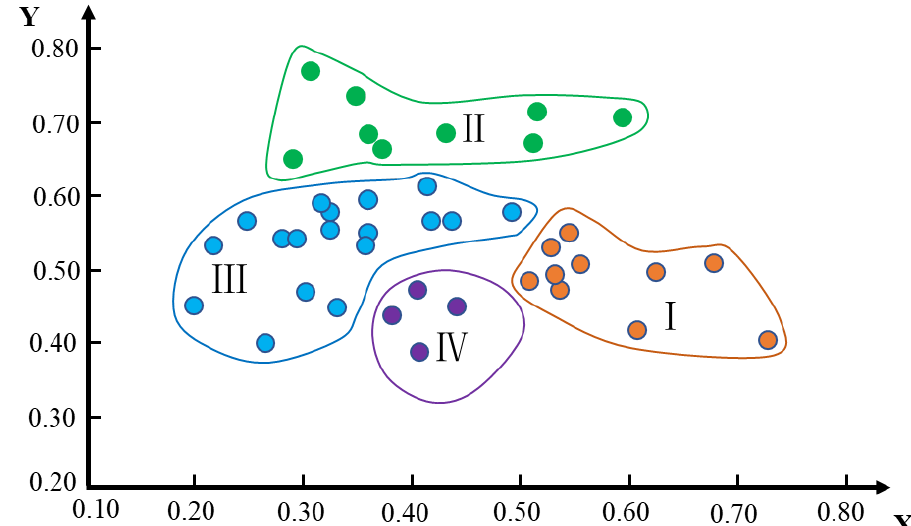
Figure 3. Grey constellation clustering results. Note: I, II, III, and IV are urban development and ecological protection type, urban development and cultivated land protection type, cultivated land improvement and ecological protection type, ecological conservation and fallow cultivation type, respectively.